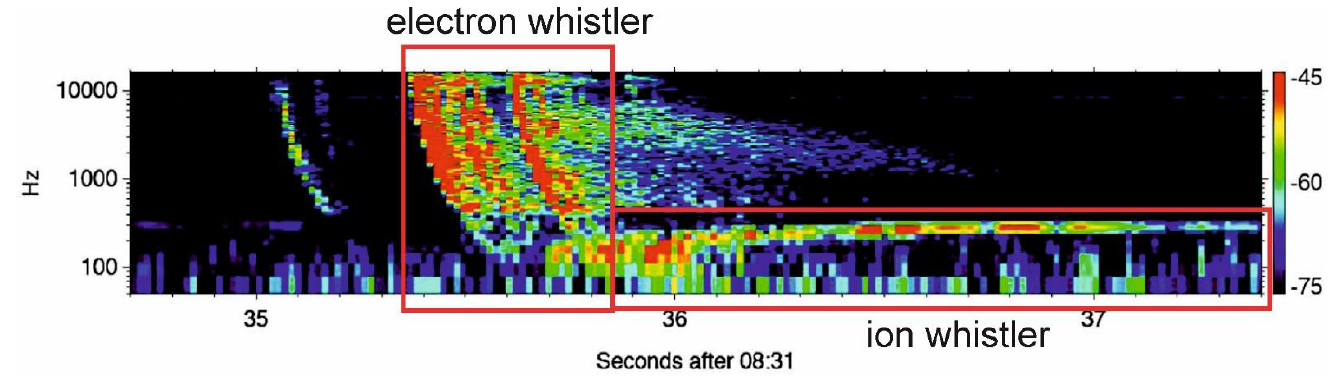
Figure 9. A whistler can consist of two parts: a high-frequency part with decaying frequency, i.e., the electron whistler; a low-frequency part with increasing frequency, i.e., the ion whistler. The frequency gap between these two parts is the lower hybrid resonance. The measurements were taken from Holzworth et al. [26] (with permission). The figure shows the detected frequency against time. The amplitude of the signal is color-coded.